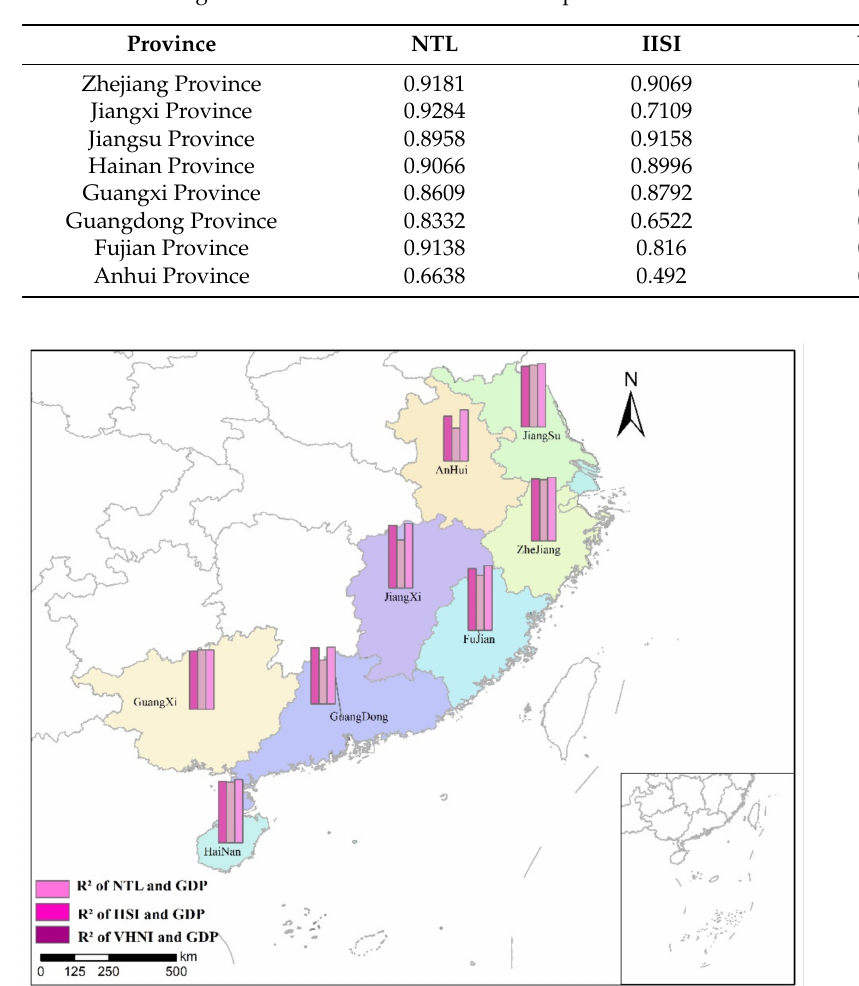
Figure 10. R 2 spatial distribution of TNL and GDP linear regression.